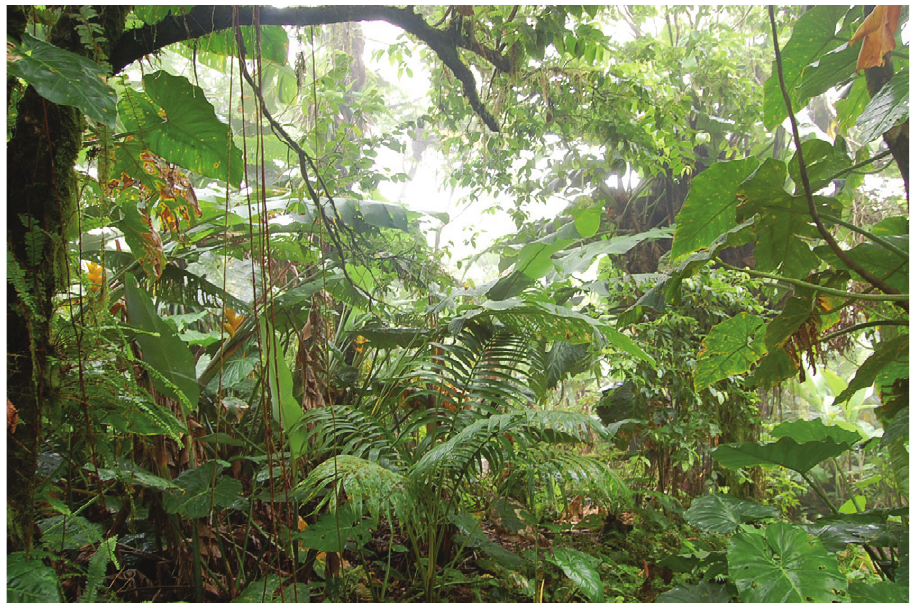
Figure 5. Habitat at the type locality of Thecadactylus oskrobapreinorum on Sint Maarten, Lesser Antilles. Photo by Maciej